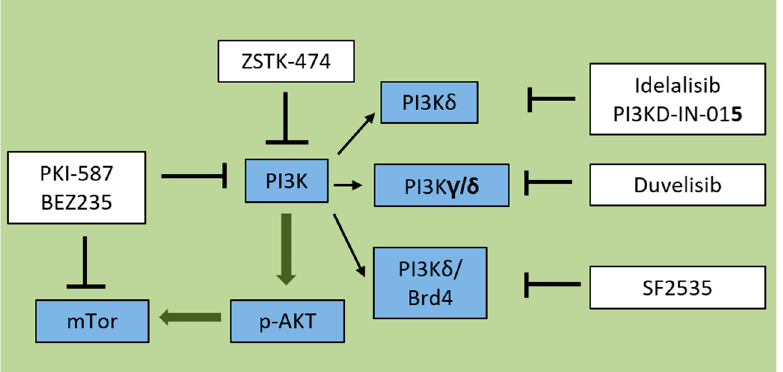
Figure 1. Phosphoinositide 3-kinases (PI3Ks) regulate cellular processes including cell survival, adhesion, and proliferation. PI3K is activated by receptor tyrosine kinases (RTKs), Integrins, or G- protein coupled receptors (GPCRS) at the surface of the cell. PI3K phosphorylates phosphatidylinositol-diphosphate (PIP2) into phosphatidylinositol triphosphate (PIP3), which in turn activate the serine/threonine kinase AKT regulations survival, adhesion and proliferation. PTEN (phosphatase and tensin homolog deleted from chromosome 10) negatively regulates PI3K signaling. = Activation; ⊥ = Inhibition